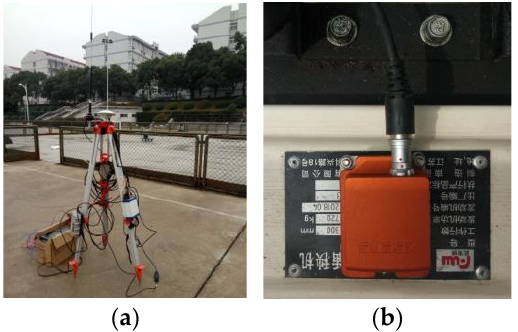
Table 4. Parameters of inertia sensor.